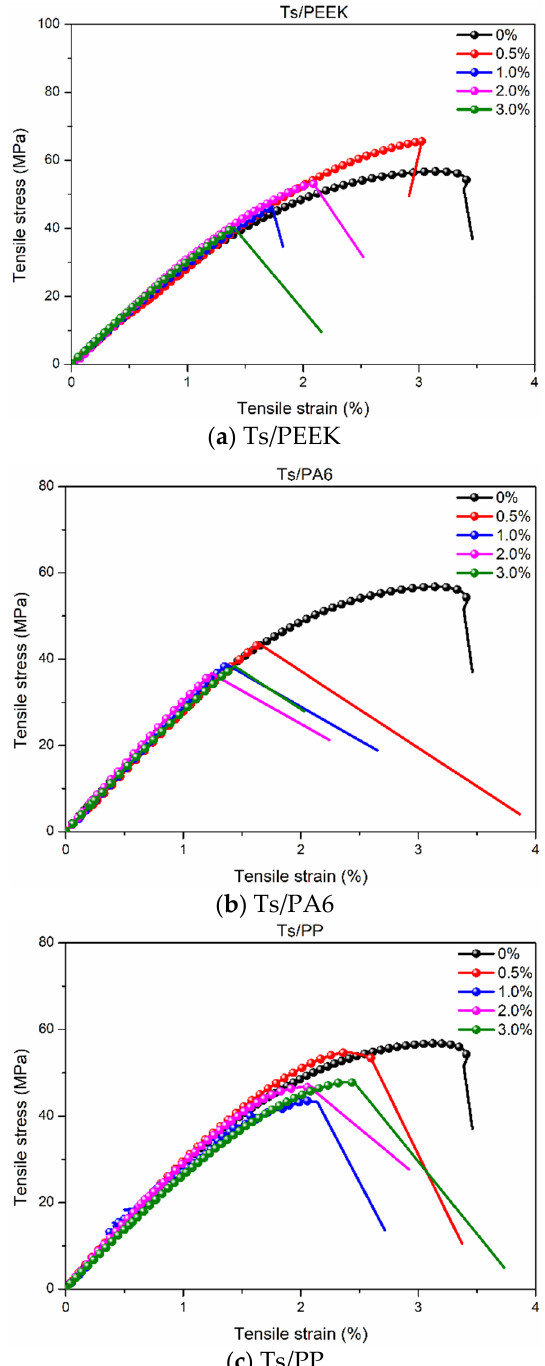
Figure 3. Effects of thermoplastic resin fillers on the tensile stress-strain curves of Ts resin of ( a ) Ts/PEEK, ( b ) Ts/PA6 and ( c ) Ts/PP.